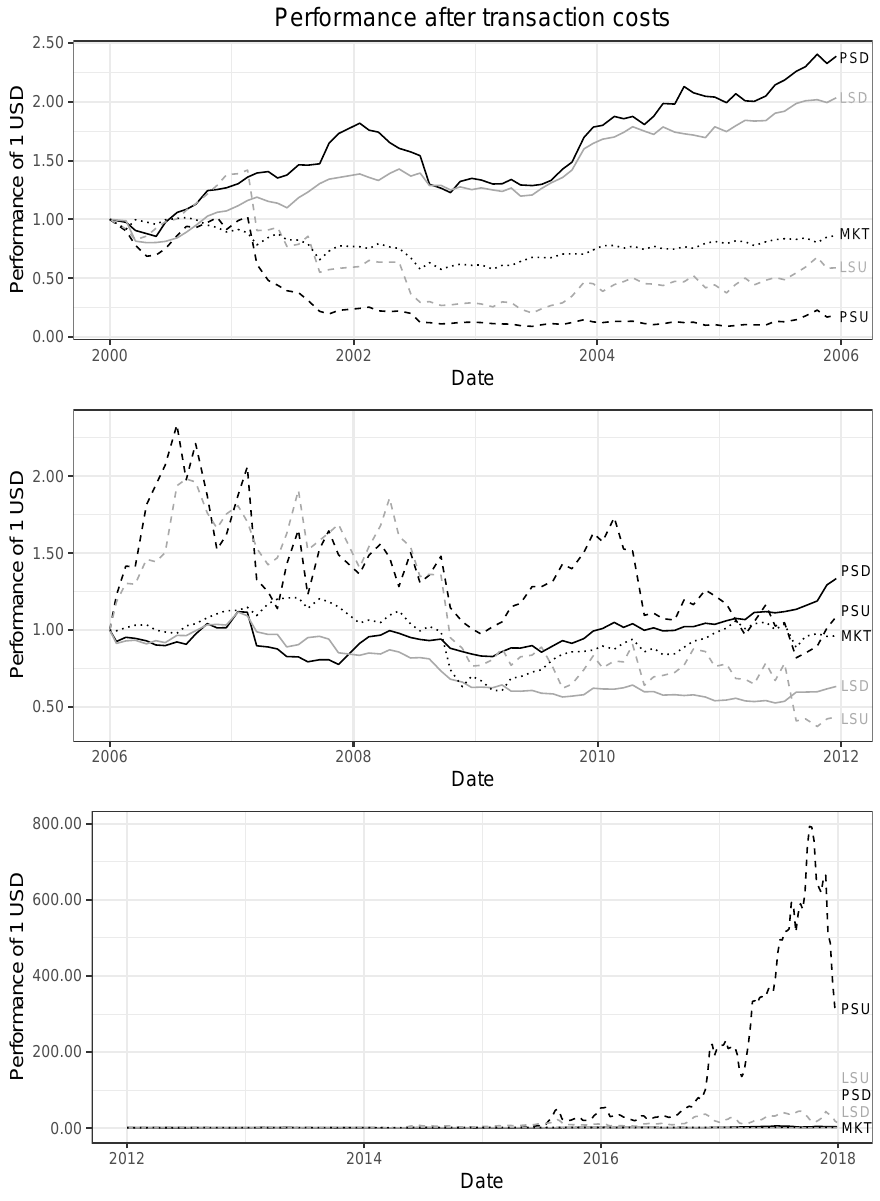
Figure 3. Development of an investment of 1 USD in PSD, PSU, LSD, and LSU after transaction costs compared to the S&P 500 (MKT). The time period is divided intro three sub-periods from January 2000–December 2005, January 2006–December 2011, and January 2012–December 2017. Source: authors’